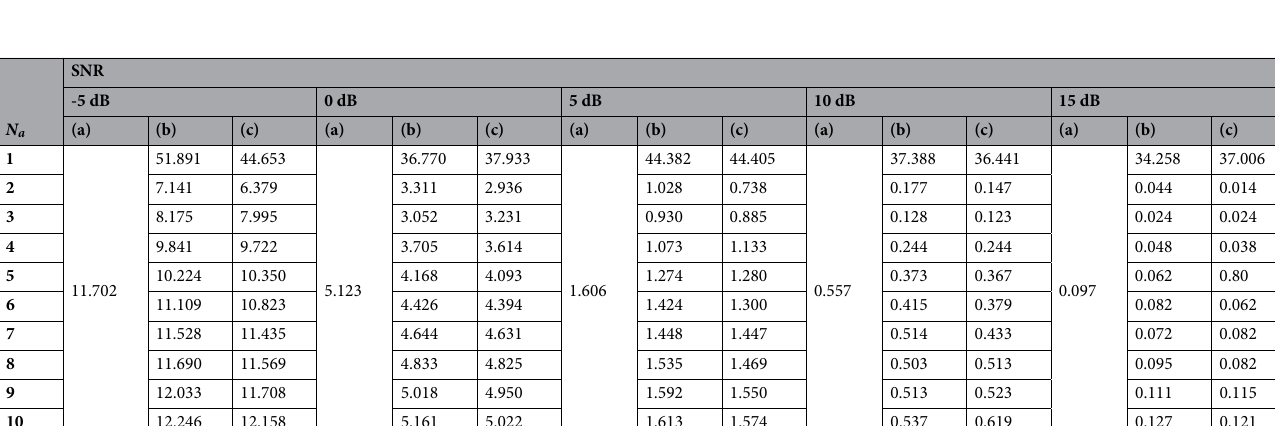
Table 1. LE of ( a ) MUSIC, ( b ) SH MUSIC, and ( c ) H